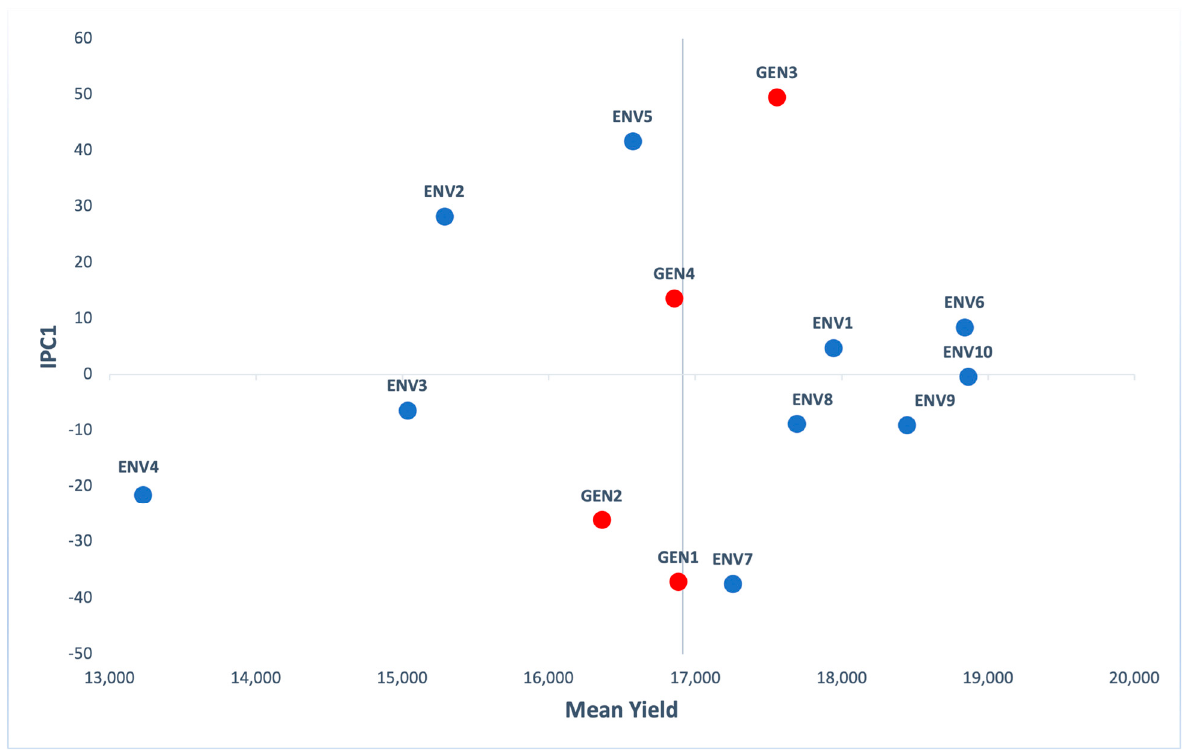
Figure 2. Additive main effects and multiplicative interaction (AMMI) biplot presenting mean grain yield (kg/ha) and the first interaction principal components axis (IPC1) of 4 genotypes (red) evaluated in 10 environments (blue). Table 2. AMMI family models for the grain yield, protein content and fiber content dataset, winning genotypes and the numbers of mega ‐ environments.